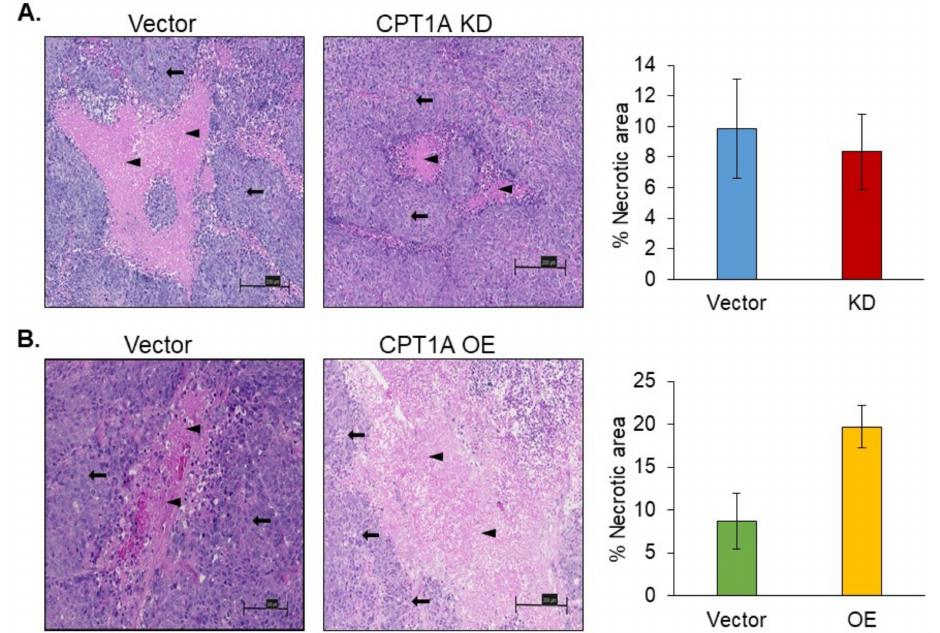
Figure 5. The measure of tumor necrosis in 22Rv1 tumors with stable knockdown or overexpression of CPT1A. Formalin- fixed tissues section were stained (H&E) and eosinophilic necrotic cells (black arrowheads) surrounded by the proliferating neoplastic cells (black arrows) forming a necrotic core at the center were analyzed in various groups. Representative images (left) and quantification of necrotic areas (right) are shown for ( A ) vector control and CPT1A KD and ( B ) and vectors control and CPT1A OE. The following numbers of the section were analyzed per group—vector control ( n = 6), CPT1A KD ( n = 7), and vector control ( n = 8), CPT1A OE ( n = 8). Sections were analyzed and presented as percentages of the necrotic area mean ± SEM. Representative photomicrographs (at 200 × magnification) are shown. Scale bar = 200 µ